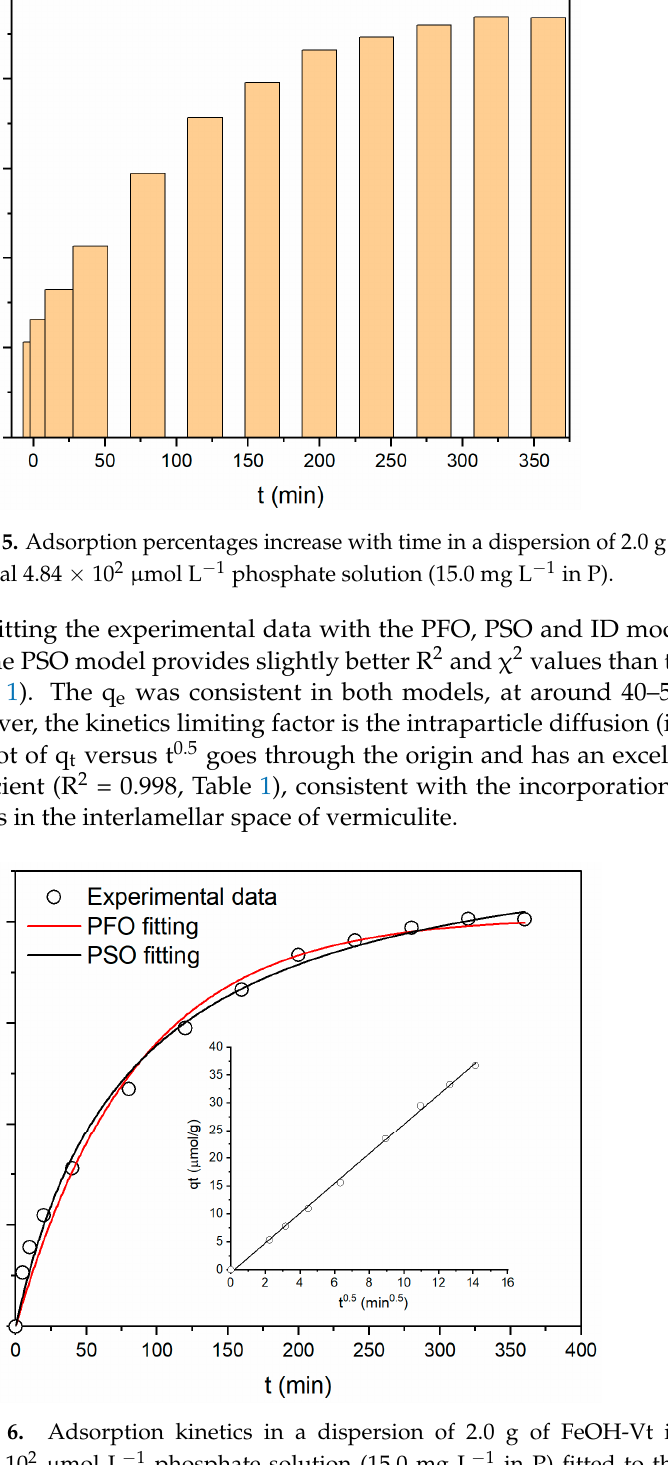
Figure 4. Dose effect investigation adopting a contact time of 200 min, initial phosphate concentration of 4.84 × 10 2 μ mol·L − 1 (15 mg·L − 1 in P) and 25.0 ± 0.5 °C.